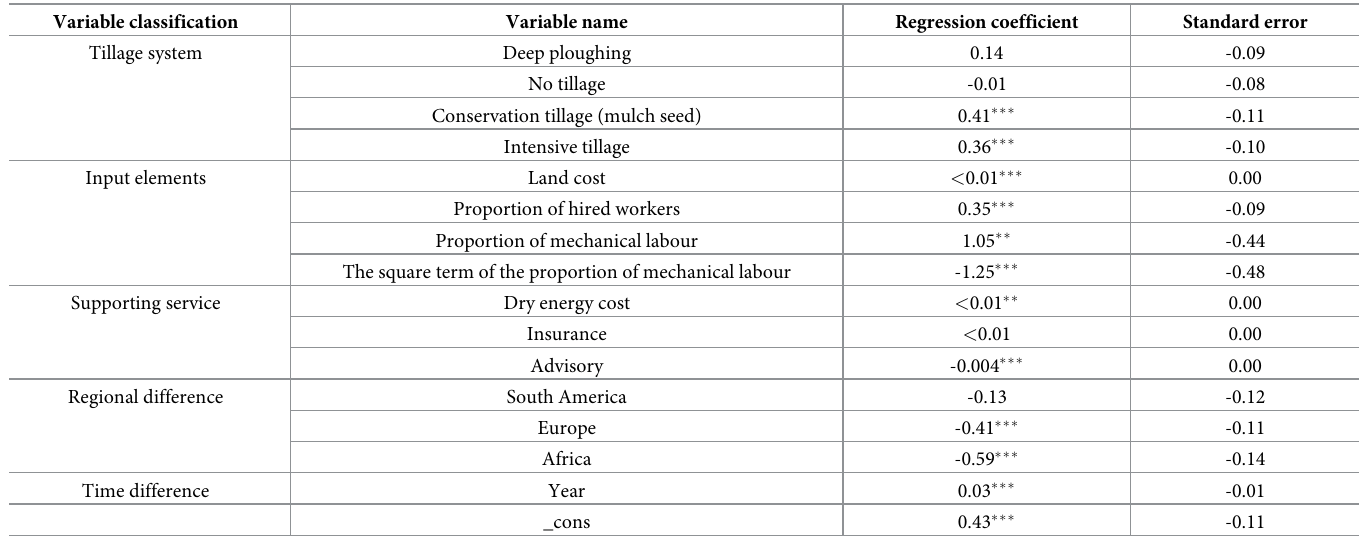
Table 5. Tobit model regression results of factors affecting corn production efficiency.